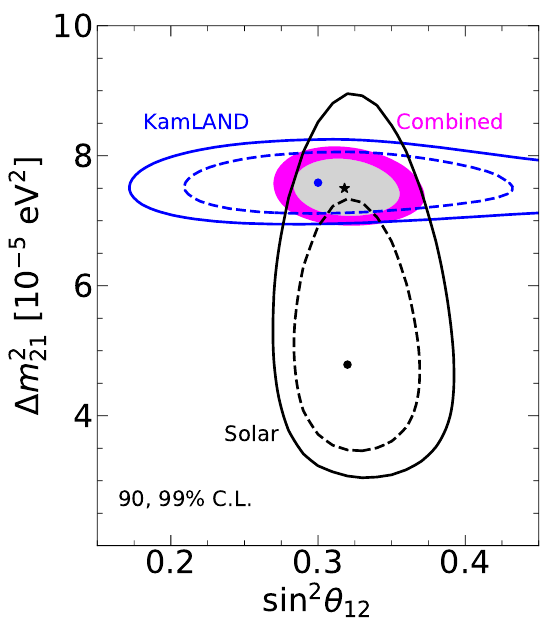
Figure 1 . 90 and 99% C.L. (2 d.o.f.) allowed regions in the sin 2 θ 12 – ∆ m 2 the analysis of solar neutrino experiments (black lines), from KamLAND (blue lines) and from the combined analysis (colored regions). The best fit values are indicated with dots for the independent analyses and with a star for the combined solar + KamLAND analysis. The reactor mixing angle θ 13 has been marginalized over without further constraint from short-baseline reactor